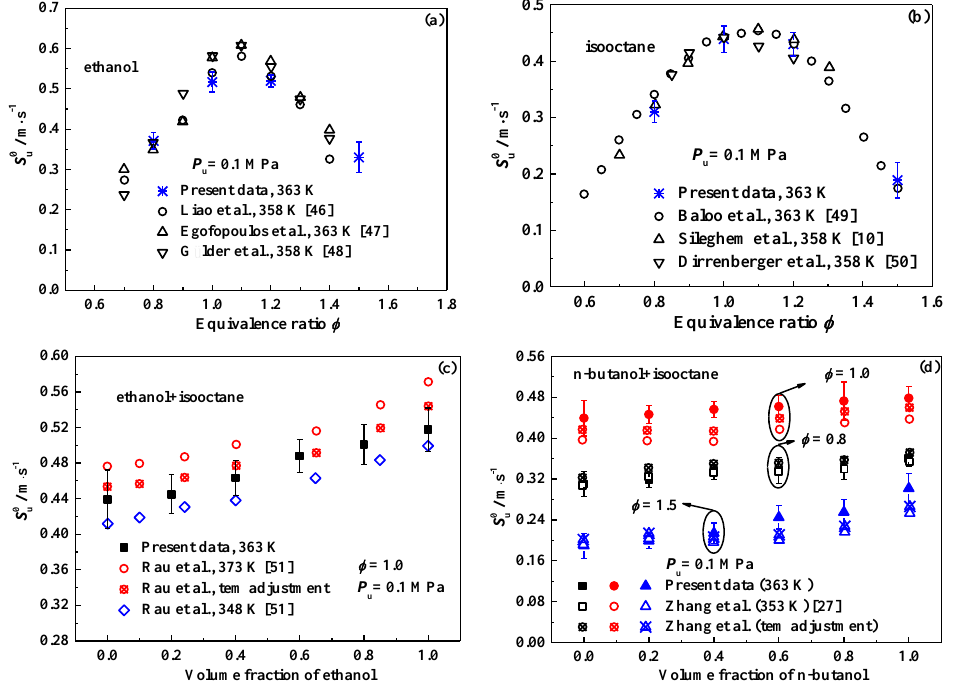
Figure 2. Laminar flame speeds of alcohol-isooctane blends acquired in present study and in literatures [10,27,46–51] at 0.1 MPa: ( a ) pure ethanol; ( b ) pure isooctane; ( c ) ethanol-isooctane blends; and ( d ) n -butanol-isooctane blends.